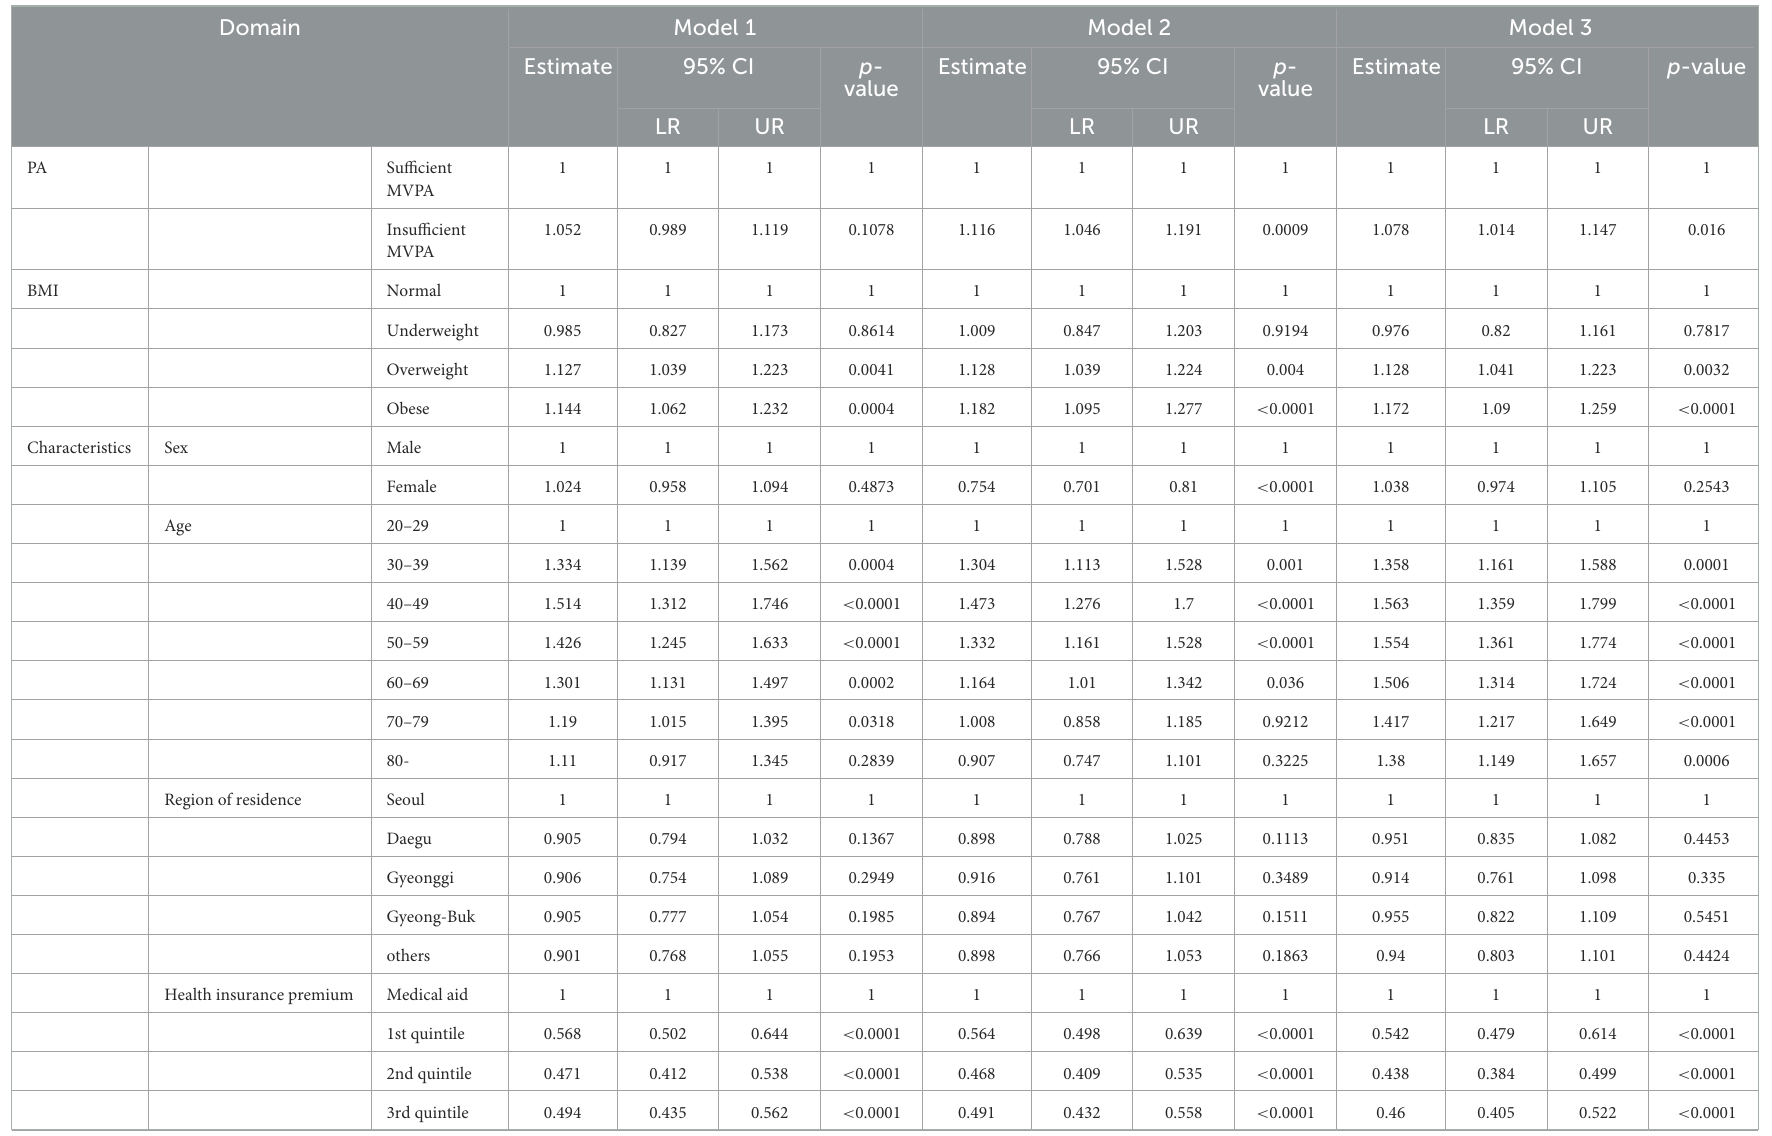
TABLE 2 Results of logistic regression analysis according to COVID-19